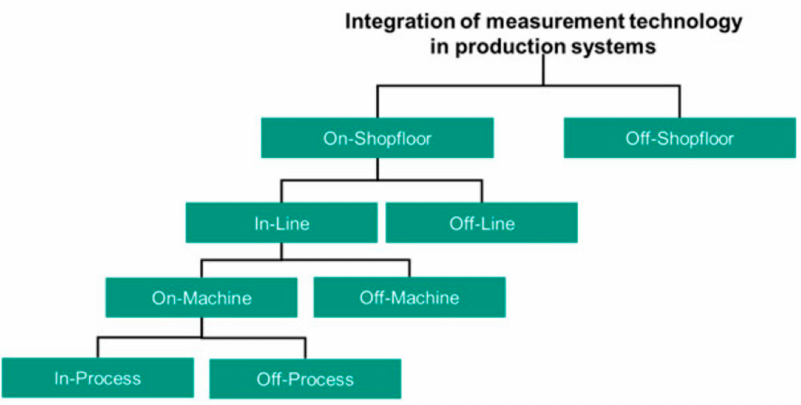
Figure 6. Nomenclature for measurement integration in production systems